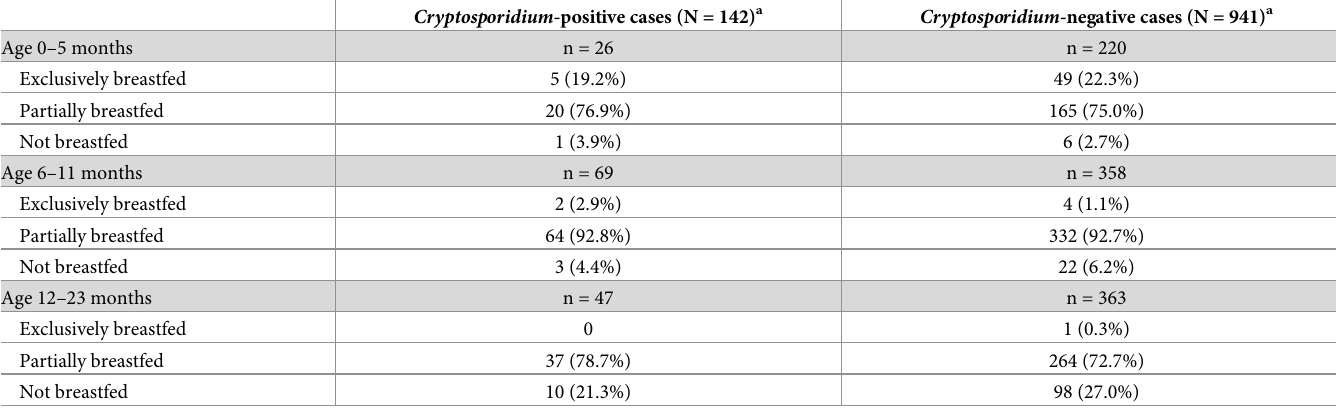
Table 4. Breastfeeding status of GEMS-Kenya cases < 24 months of age (N = 1,083) by Cryptosporidium status, western Kenya,